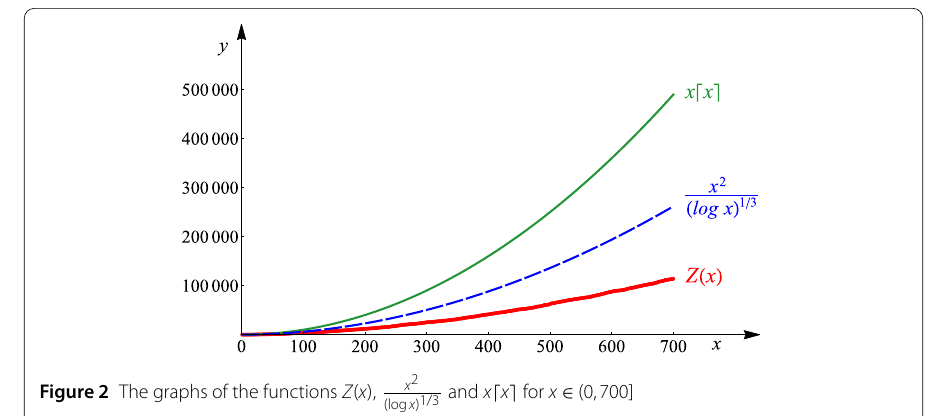
Figure 2 The graphs of the functions Z ( x ), x 2